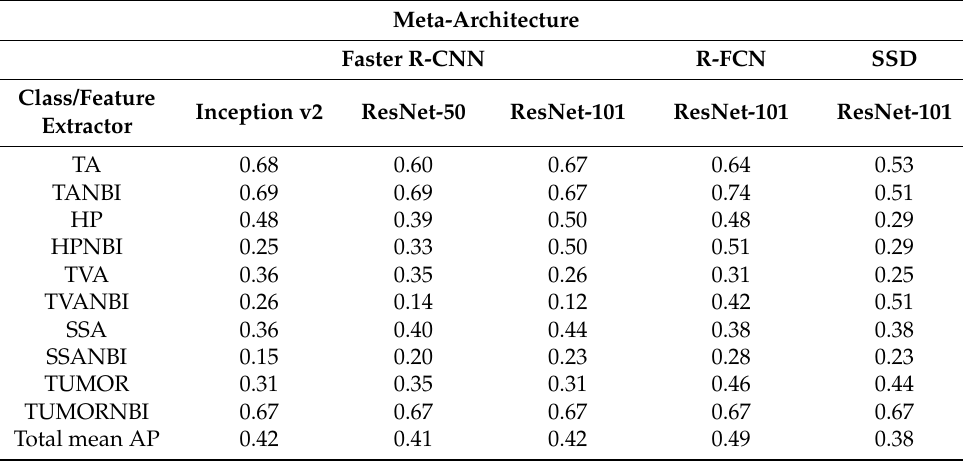
Figure 7. Detection outcomes of HP and SSA with and without NBI (blue box: expert annotated region, other: machine prediction). Table 2. The mAP outcomes of Faster R-CNN, R-FCN and SSD.